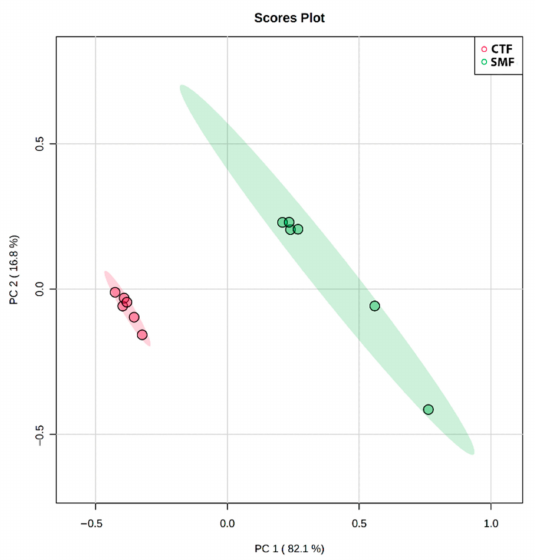
Figure 5. Principal component analysis (PCA) of VOCs with e-nose Cyranose 320 sensor response to two types of F-MC manufactured with milk from different dairy breeds. (Red indicates F-MC made with milk from Holstein cows, green represents F-MC made with milk from Jersey